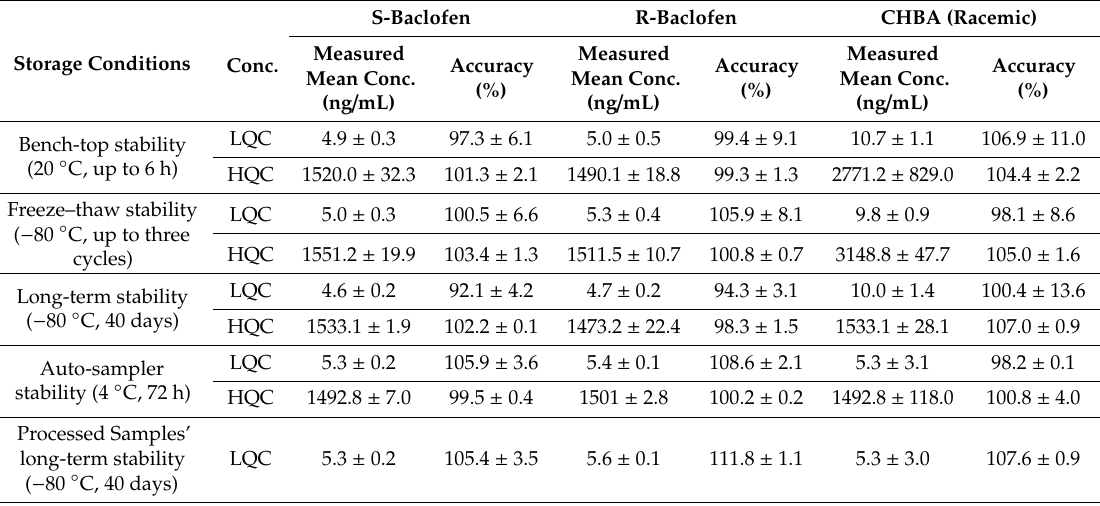
Table 4. Mean stability recoveries of baclofen and its metabolites at di ff erent storage conditions in human